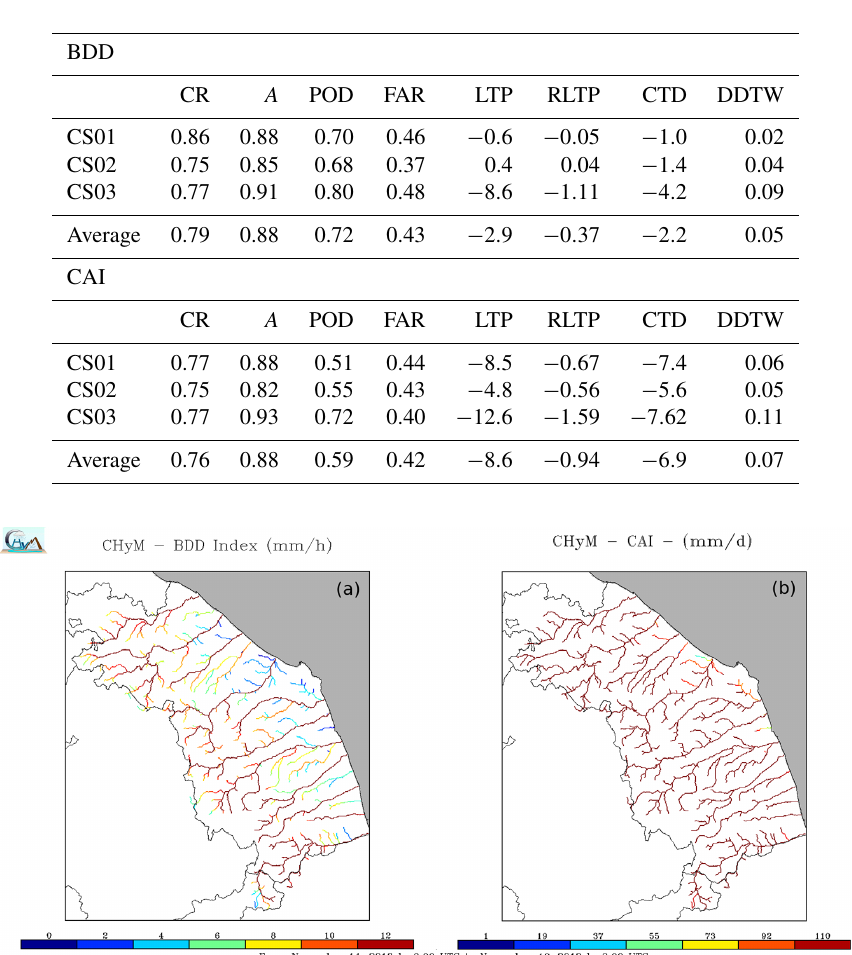
Table 5. CAI and BDD index scores for all CSs. Values for single CSs are averages calculated over all hydrometric stations located in the domain.